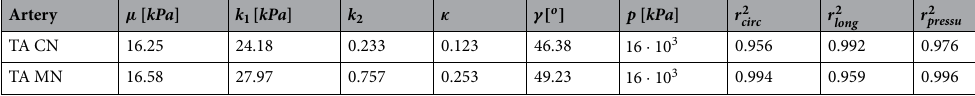
Table 1. Material parameters of the GHO model for aorta artery and correlation indicators for tensile curves ( r 2 circ and r 2 long ) and pressurization curves ( r 2 press ).